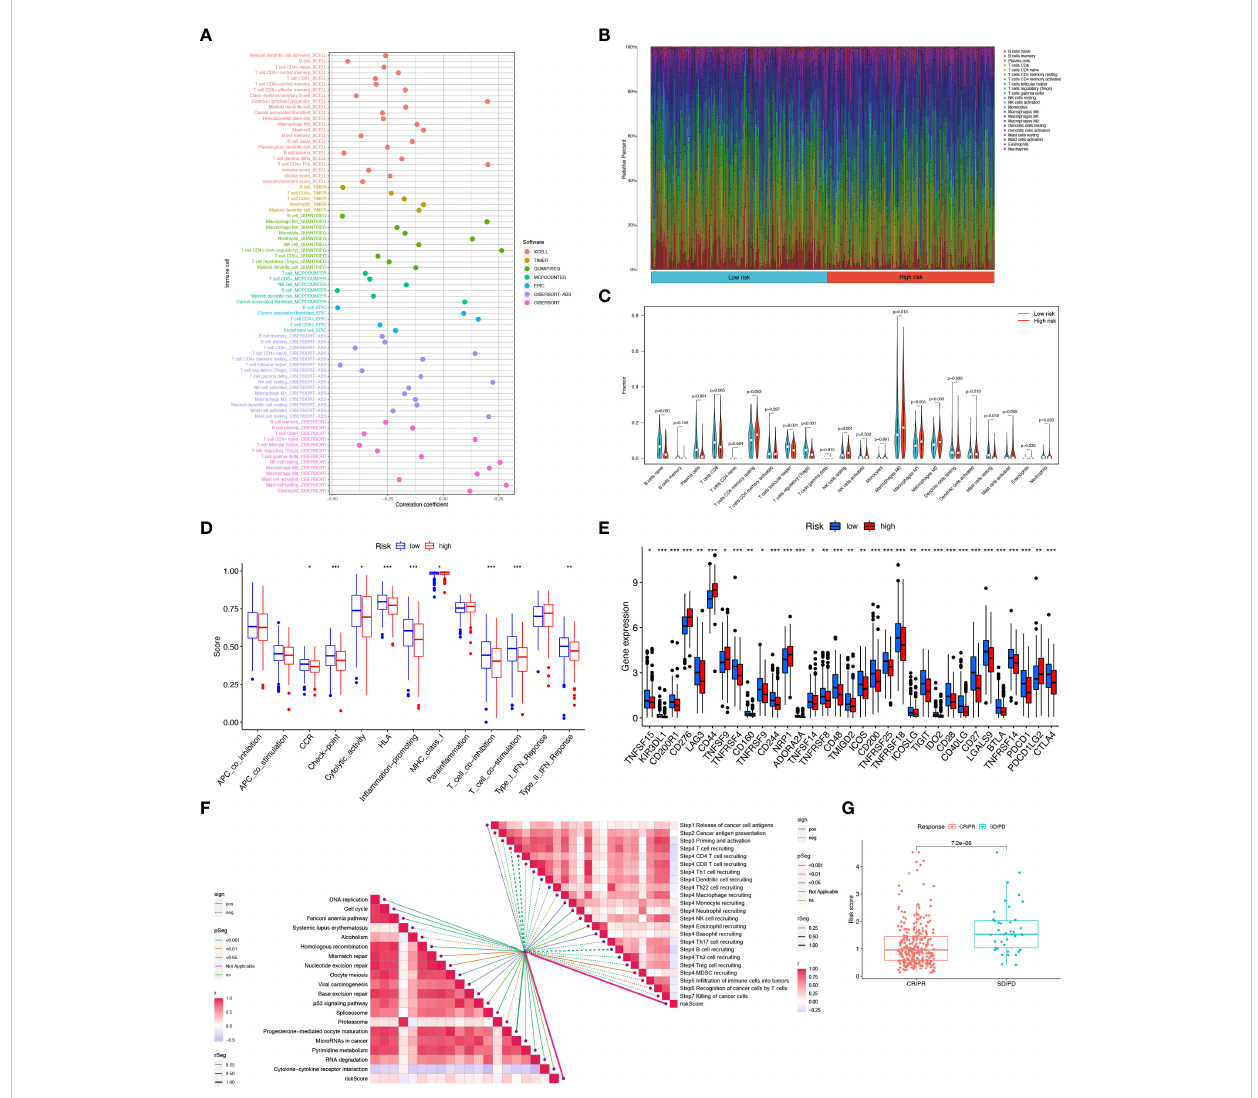
FIGURE 9 6-CRRGs risk score predicts TME and immune cell in fi ltration. (A) Immune cell bubble map. (B) Barplot showing the proportion of 22 kinds of TICs in HNSCC tumor samples. (C) Differences in immune cell in fi ltration between high- and low-risk groups. (D) Immune cell and immune function ssGSEA scores between high- and low-risk groups. (E) Immune checkpoint differences between high- and low-risk groups. (F) Correlation between risk score and ICB response signature. And the correlation of risk scores with each step of the tumor immune cycle. * P < 0.05; ** P < 0.01; *** P < 0.001 (G) Correlation between risk scores and clinical response to cancer